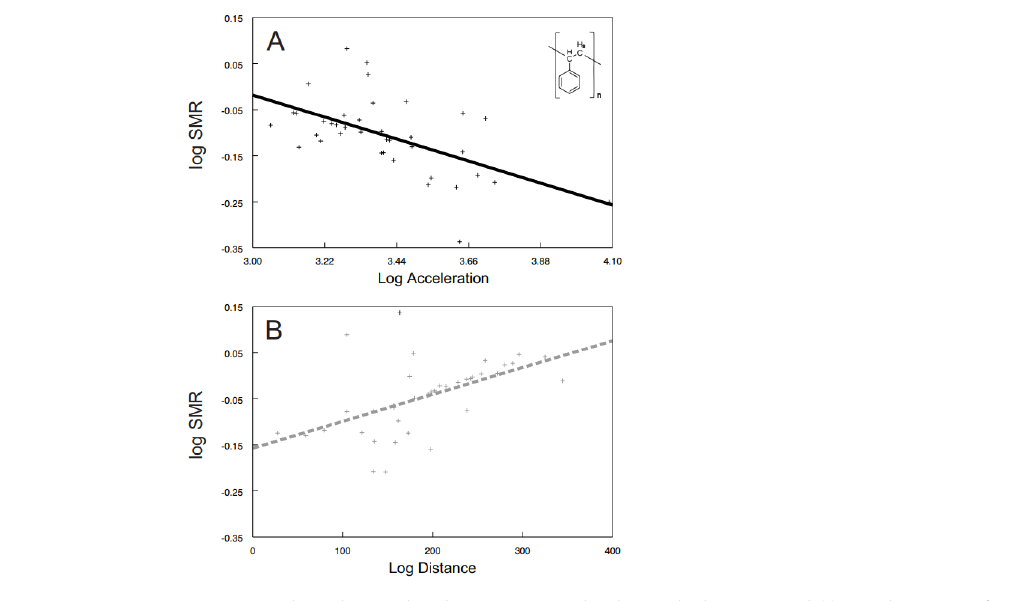
Figure 6. The relationship between standard metabolic rate and (i) acceleration of exposed shrimps ( A ); black full line; polystyrene formula showed) and (ii) distance of control shrimps ( B ); grey dashed line). Predicted values are from particular LMM models. The curves were fitted by: ( A ) y = − 0.2171x + 0.6331 (r 2 = 0.32); ( B ) y = 0.0006x − 0.1571 (r 2 = 0.28).